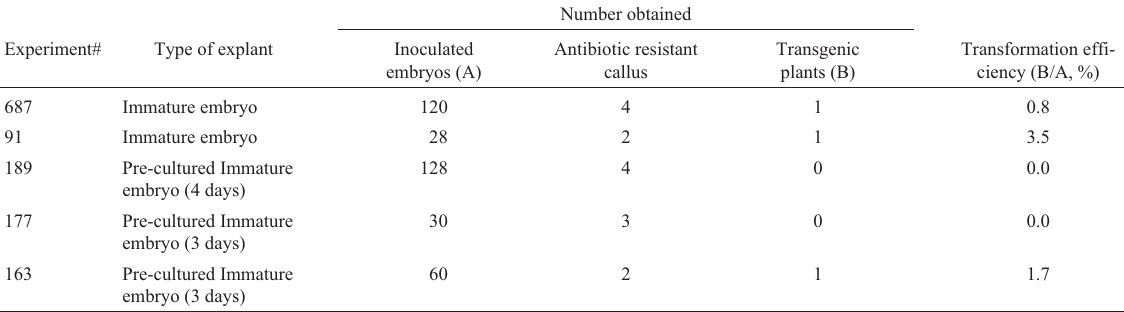
Table 6 - Transformation efficiency relative to the experiments in which resistant callus or transgenic plants were produced.